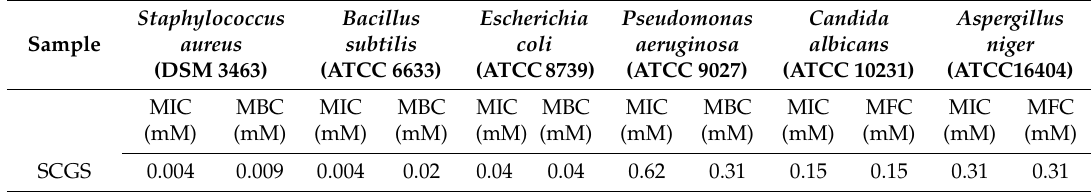
Table 2. The minimum inhibitory concentration (MIC), the minimum bactericidal concentration (MBC), and the minimum fungicidal concentration (MFC) of the SCGS against di ff erent standard microbial strains. The result was represented as the mean of the samples concentrations (mM) with zero standard deviations